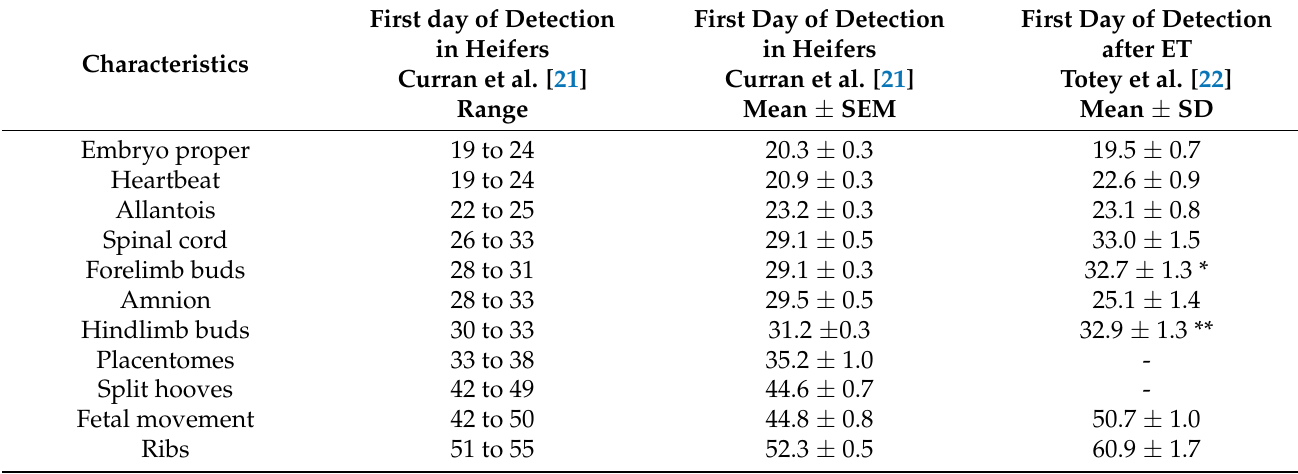
Table 1. Identifiable characteristics of the bovine conceptus during ultrasonographic examinations for pregnancy diagnosis, indicating the first day of